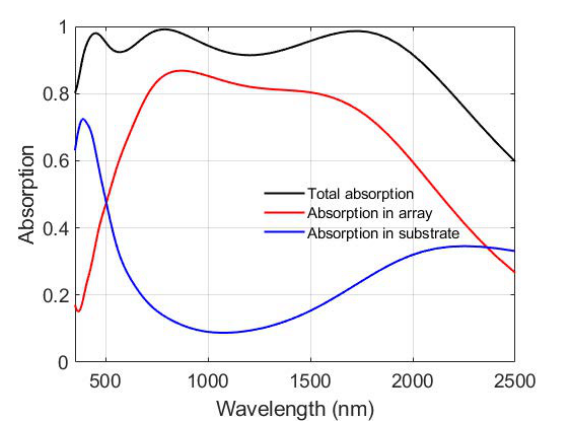
Figure 7. Absorption spectra of the different parts of the SiO 2 /patterned-TiN/SiO 2 /TiN stacks. The size parameters of the structure are the thickness of the patterned-TiN layer 20 nm, diameter of the disk 240 nm, period of the array 300 nm, and thickness of the SiO 2 layers 85 nm.